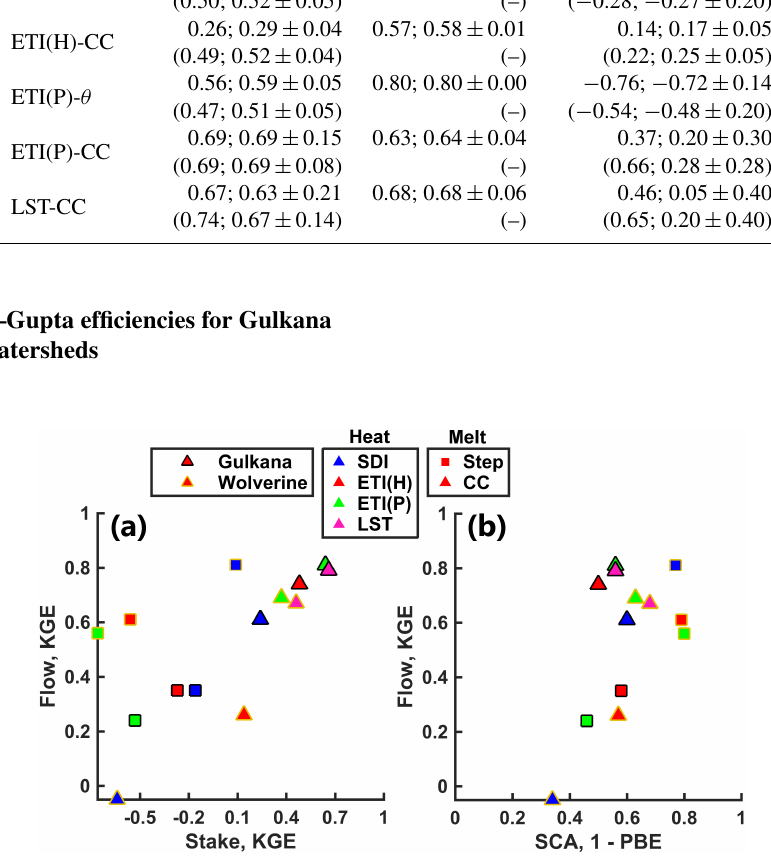
Figure B1. Model flow performance during validation as a function of SCA and stake performance. The marker border indicates phase of assessment, face color indicates heat module representation, and shape indicates mass flux module representation, as described in the legends. (a) displays KGE scores for stake measurements and flow. (b) displays 1 minus the PBE score for SCA and the KGE score for